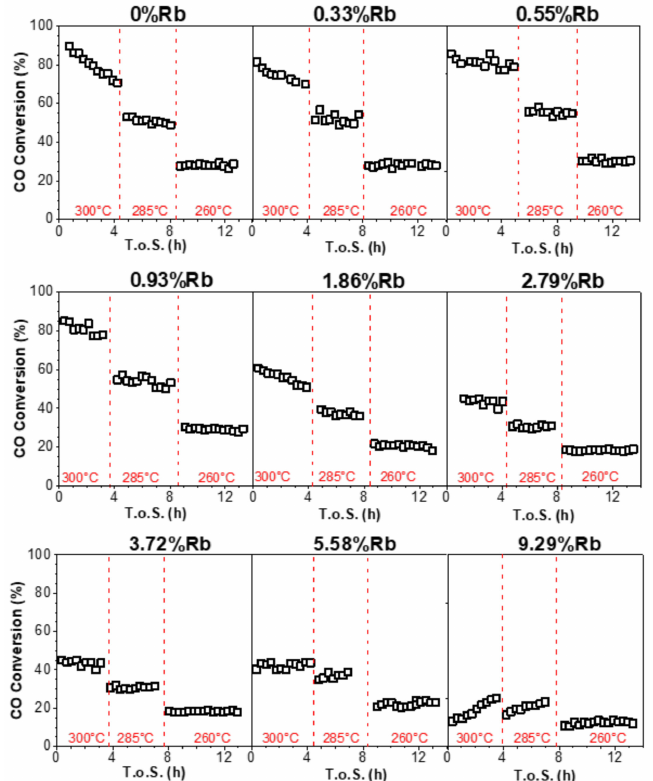
Figure 20. CO conversion vs. time on stream during LT-WGS for 2%Pt/ZrO 2 and the same cata- lyst doped with various amounts of rubidium (26.1%H 2 O, 2.9%CO, 29.9%H 2 , 4.3%N 2 , 36.8% He, P = 1 atm, SV = 167,638 Ncc/h · g cat